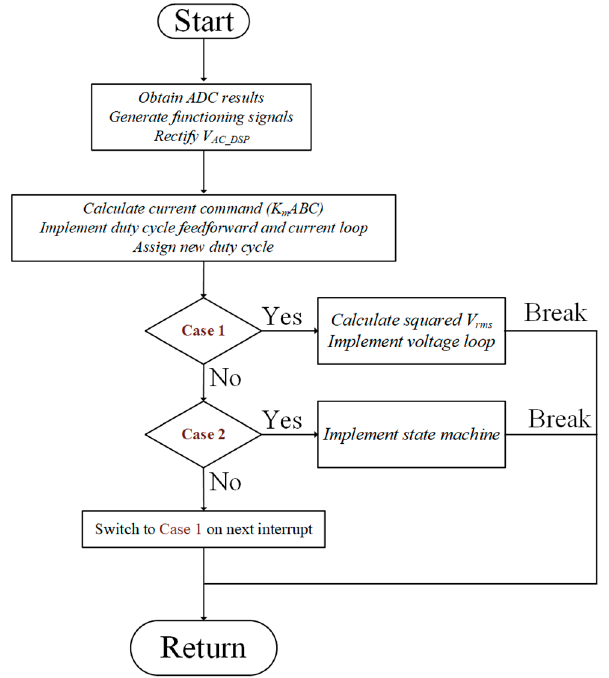
Figure 7. The principal software flowchart of the proposed control structure.